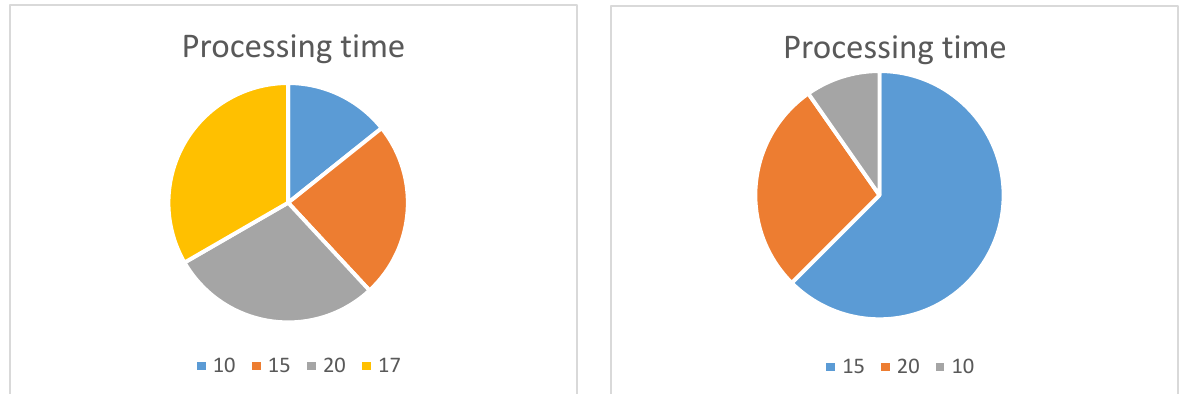
Figure 5. Estimated processing time in min for ECG.